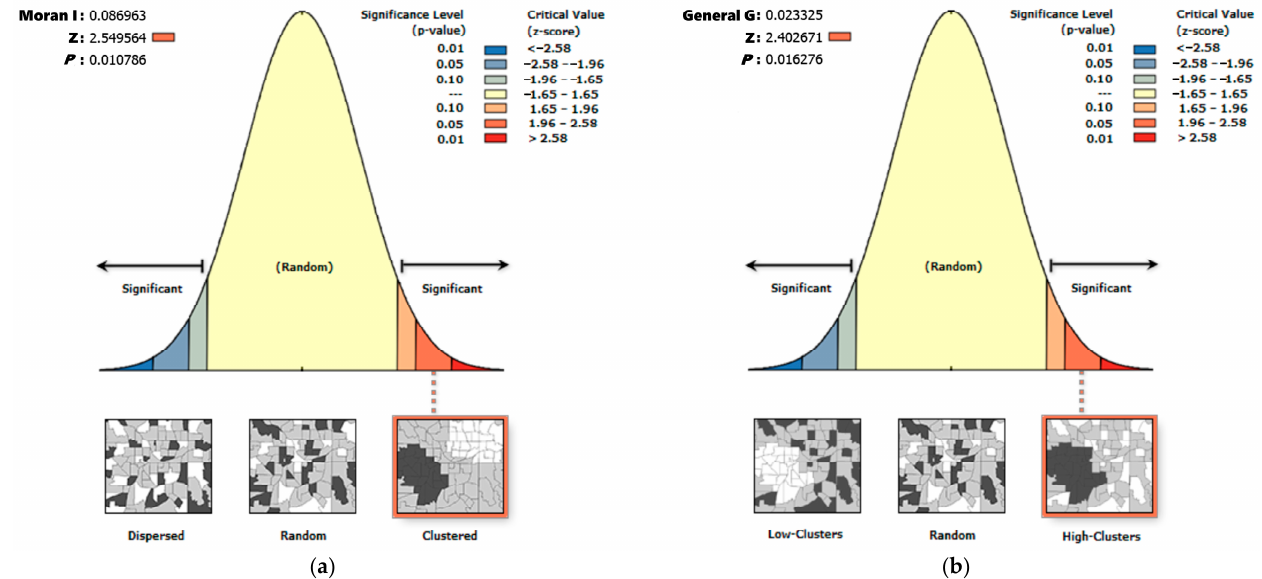
Figure 9. ( a ) Space autocorrelation statement; ( b ) High/low clustering analysis (images provided by ArcGIS Screenshot).